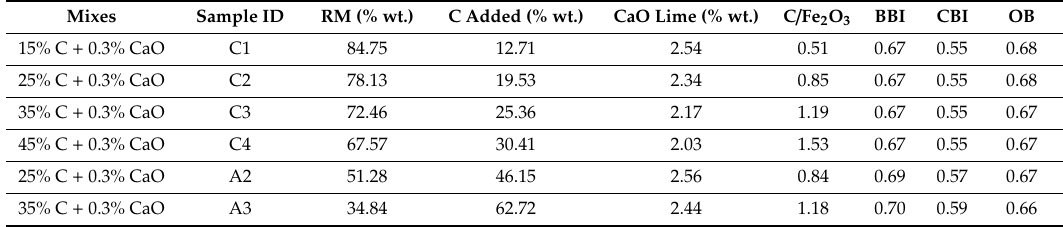
Table 4. Chemical composition (% weight), C / Fe 2 O 3 ratio, and basicity indexes of red mud /